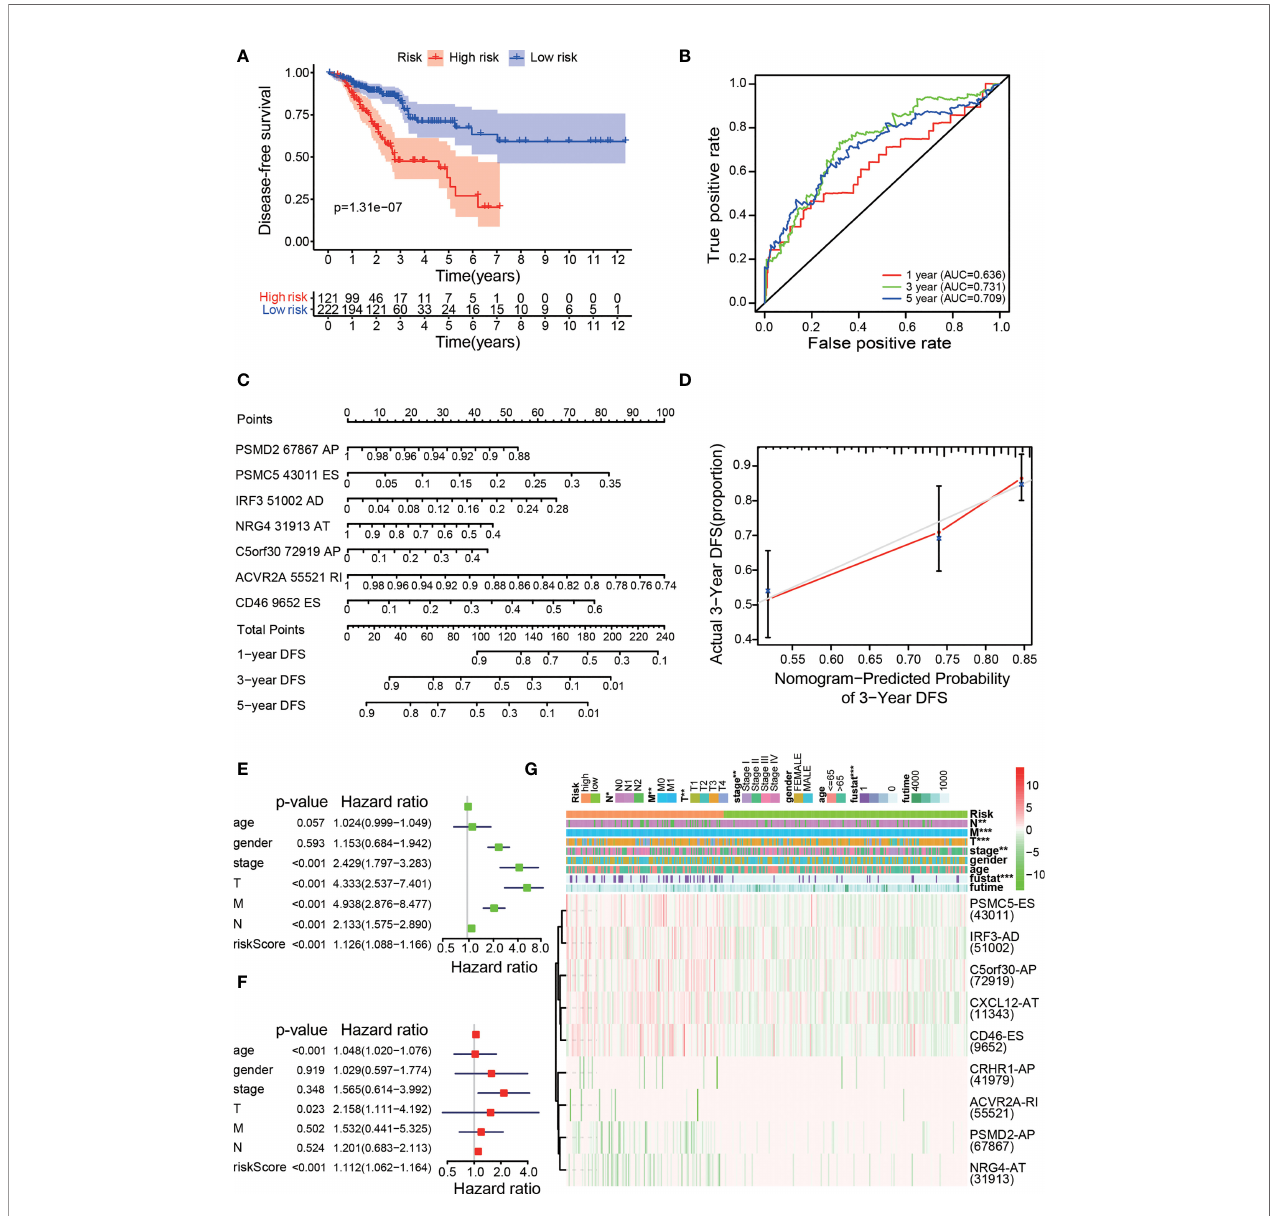
FIGURE 4 | Clinical evaluation of the prognostic risk model. (A) Kaplan – Meier curve for DFS prediction of colon cancer patients. (B) The 1-, 3-, and 5-year ROC plots of the prognostic model for predicting DFS outcomes. (C) Nomogram for predicting DFS probabilities. (D) Calibration curve for evaluating the accuracy of the DFS nomogram using 3-year DFS data. Univariate Cox regression (E) and multivariate Cox regression (F) analyses of clinical parameters and the risk score, in which the P values of the risk score were both less than 0.001, indicated that the risk score can act as an independent prognostic factor in colon cancer. (G) A strip chart along with a scatter diagram showing that T stage, N stage, M stage, clinical stage, and survival status were signi fi cantly related to the risk score. The bottom heatmap displays the scatter of each OS-ASE (the green and red colours correspond to low and high PSI values, respectively). *p < 0.05, **p < 0.01, and ***p <